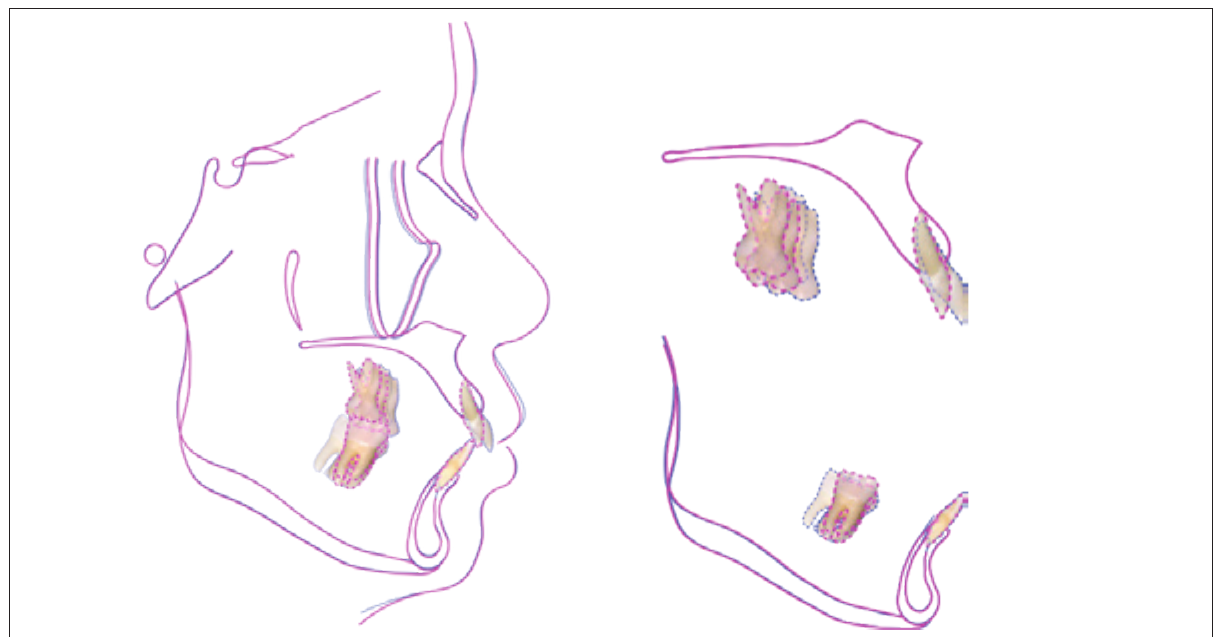
Figure 6. Superimposed pretreatment (blue line) and post-treatment (purple line) cephalometric tracings. The upper lip was retracted and MPA was